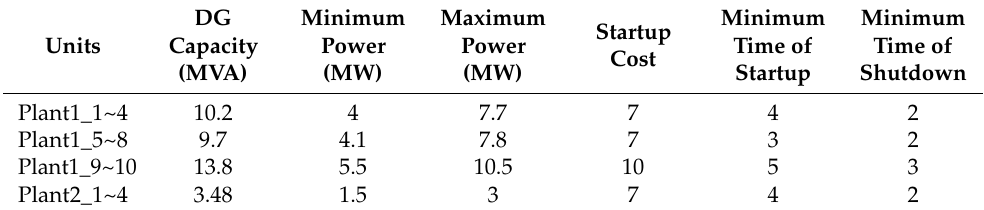
Table 1. The simulation parameters of the diesel generators.